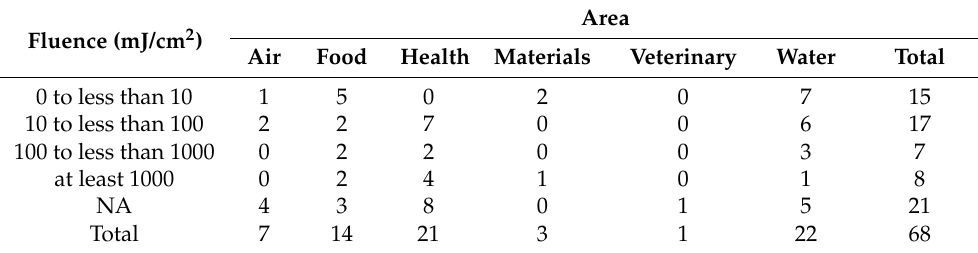
Table 2. Fluencies according to the scientific